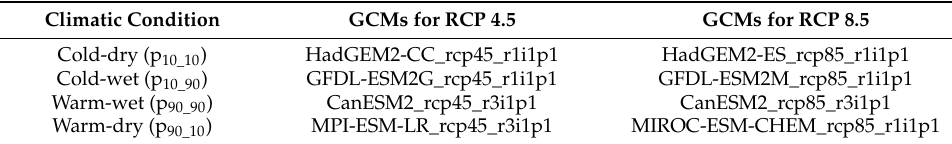
Table 1. Summary of selected GCMs for RCPs 4.5 and 8.5.